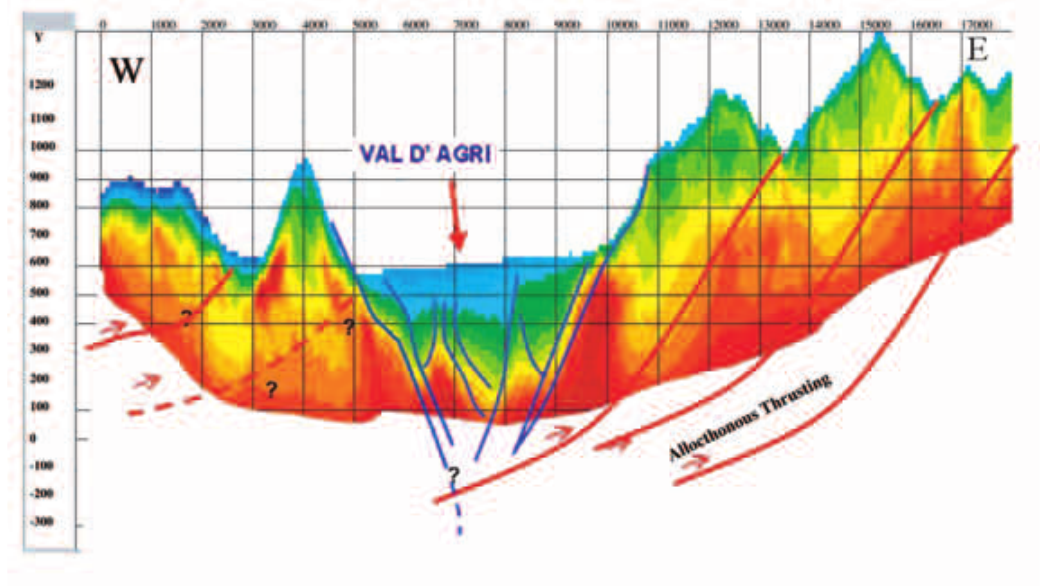
Fig. 14. Near surface tomography velocity – depth section – structural interpretation of the Val d’Agri graben in the wider context of the Apennine trust